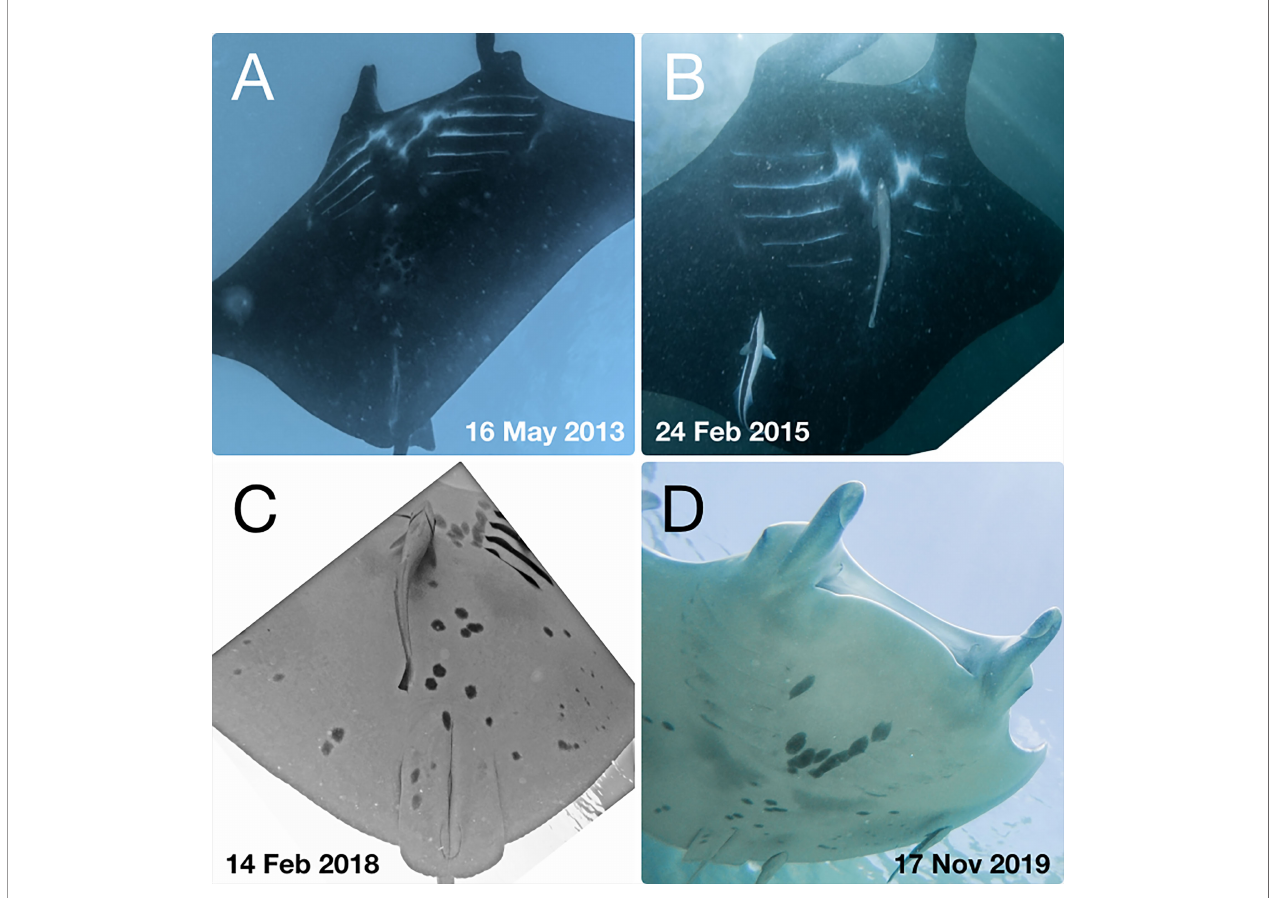
FIGURE 2 | Example of resighted juvenile M. alfredi RA-MA-1322 (A, B) and RA-MA-0525 (C, D) within the Wayag lagoon, Raja